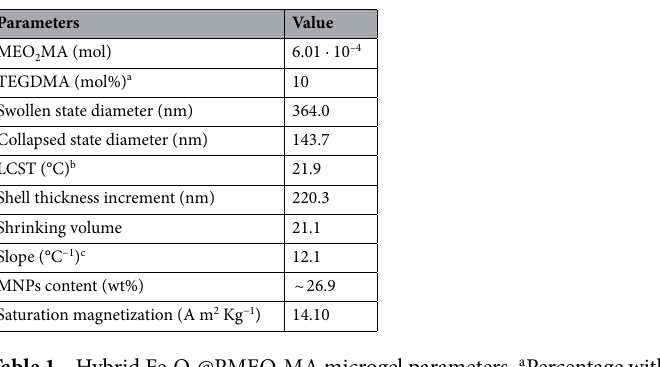
Table 1. Hybrid Fe 3 O 4 @PMEO 2 MA microgel parameters. a Percentage with respect to the molar content of